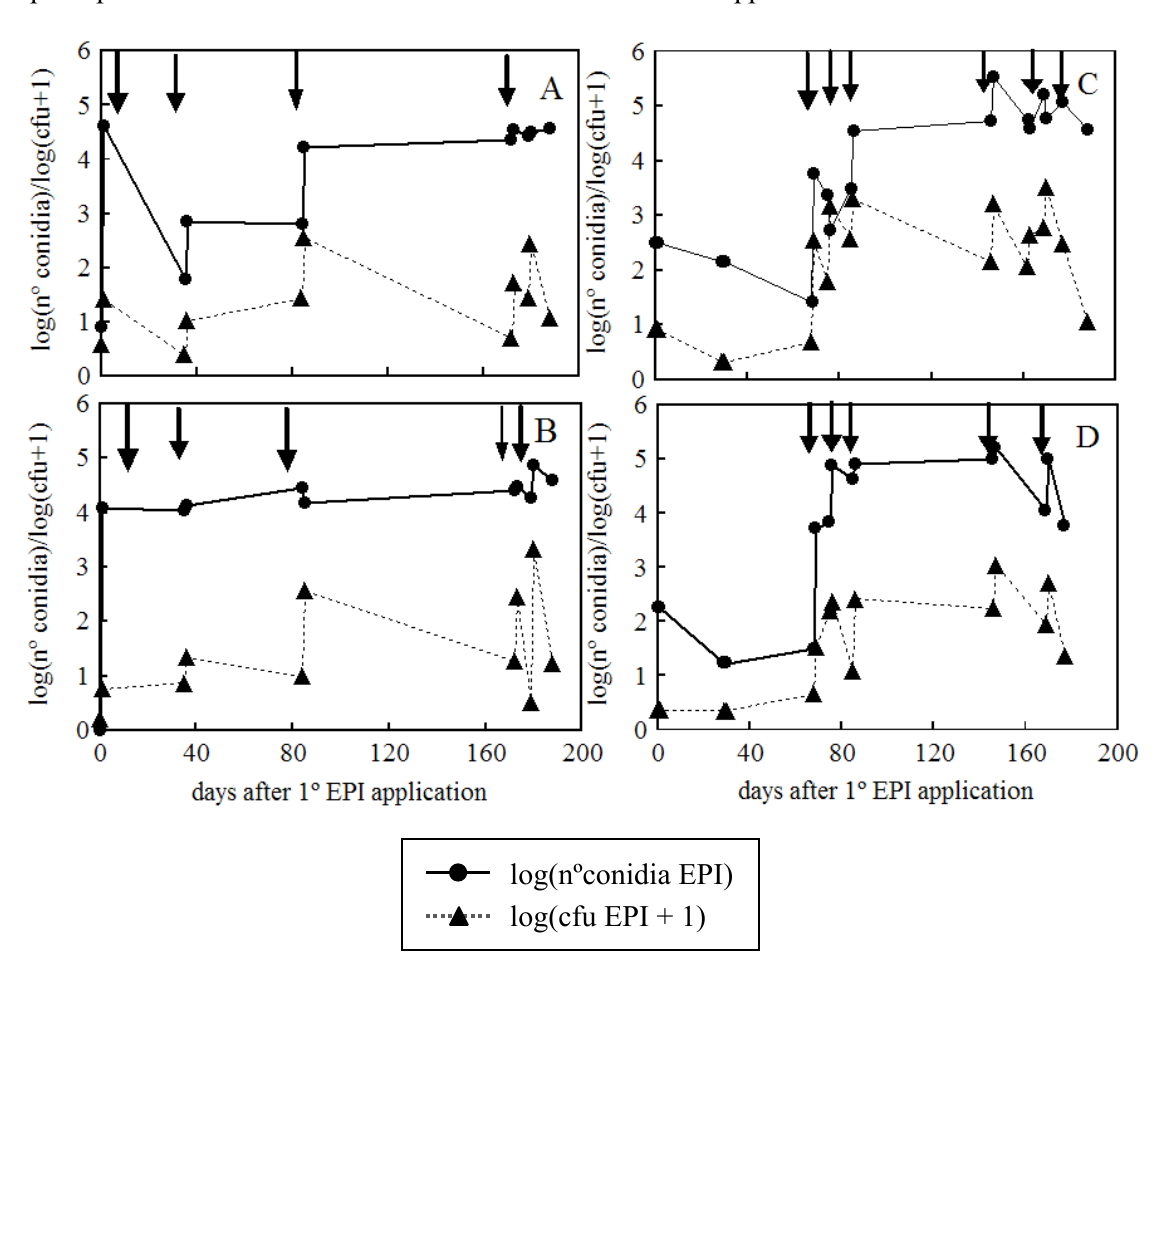
Figure 1. Population dynamics of Epicoccum nigrum (EPI) after five or six applications of the FOR7 E. nigrum conidial formulation. The data are displayed as the logarithm of the number of conidia and the number of colony-forming units (CFU + 1) that were recovered from flowers or fruit in ( A ) 2004 and ( B ) 2005 in a commercial orchard in Alfarrás, Spain, and in ( C ) 2004 and ( D ) 2005 in a commercial orchard in Sudanell, Spain. The number of E. nigrum conidia was counted in a hemocytometer under a light microscope (×100). The numbers of CFUs of E. nigrum per square centimeter of surface of the Petri dish that contained potato dextrose agar that was supplemented with 0.5 g L − 1 streptomycin were counted with the naked eye. Data are the mean of four replicates, with 10 flowers or five fruits per replicate. The vertical arrows show the times of the EPI